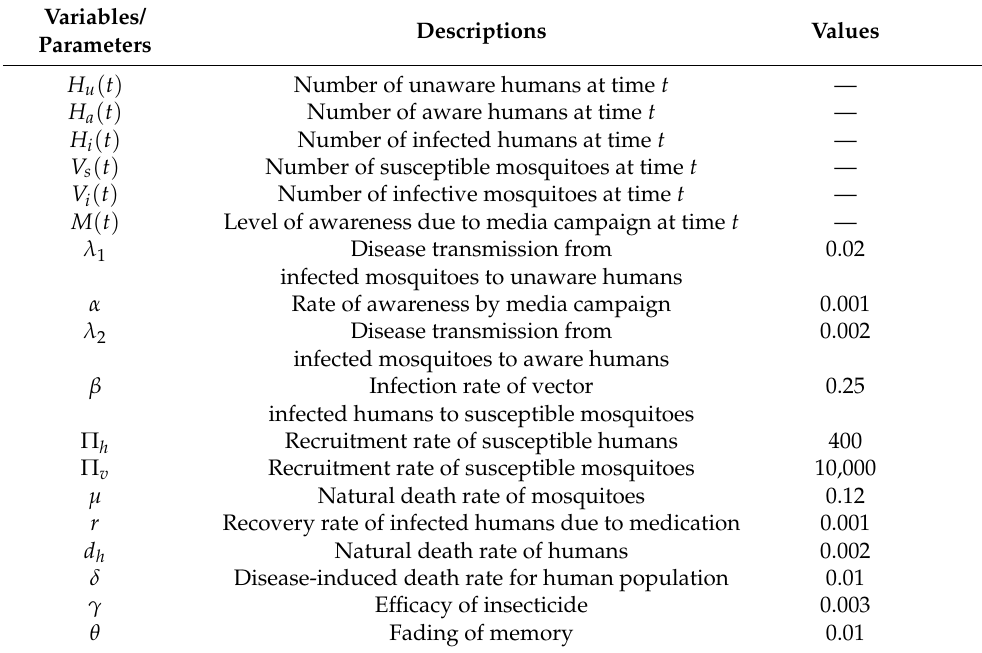
Figure 2. Forward transcritical bifurcation: equilibrium values of ( a ) infected human and ( b ) infective vectors are plotted with respect to the basic reproduction number the rest of the parameters’ values are taken from Table 1. Table 1. Biological meanings of variables, parameters used in the model (1), and values of the parameters used for numerical simulations